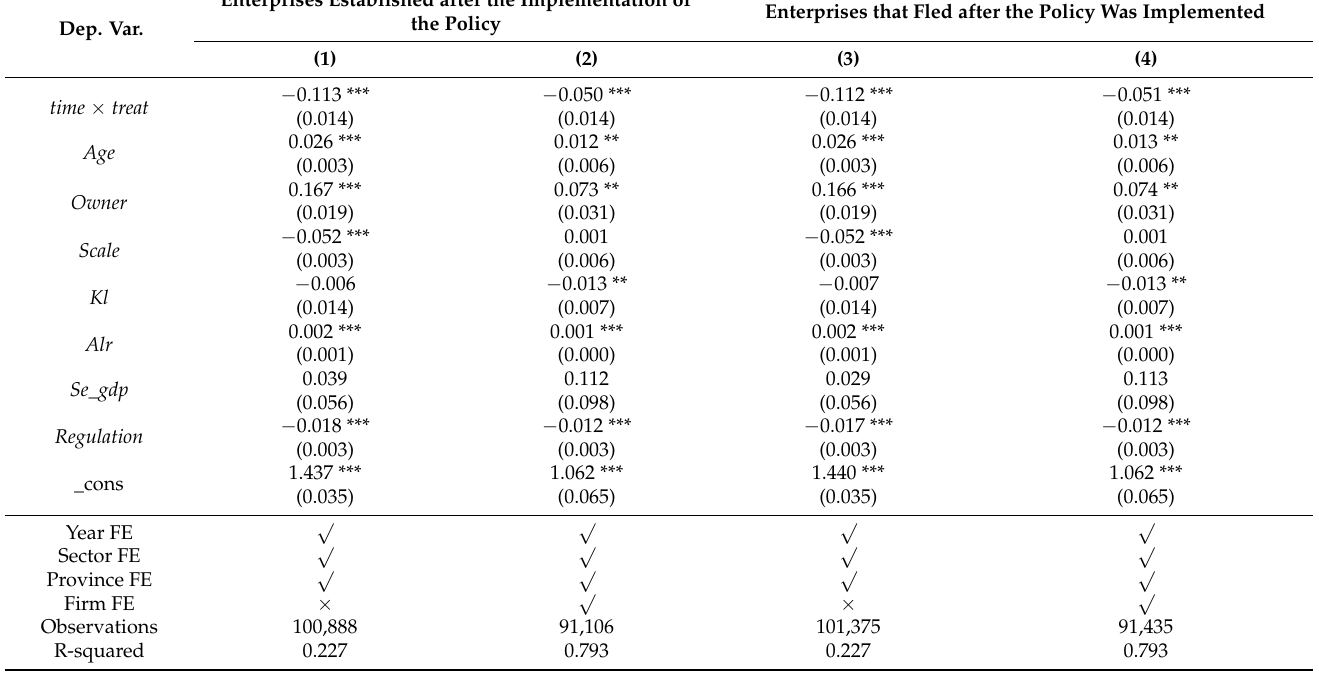
Table 8. Excluding special